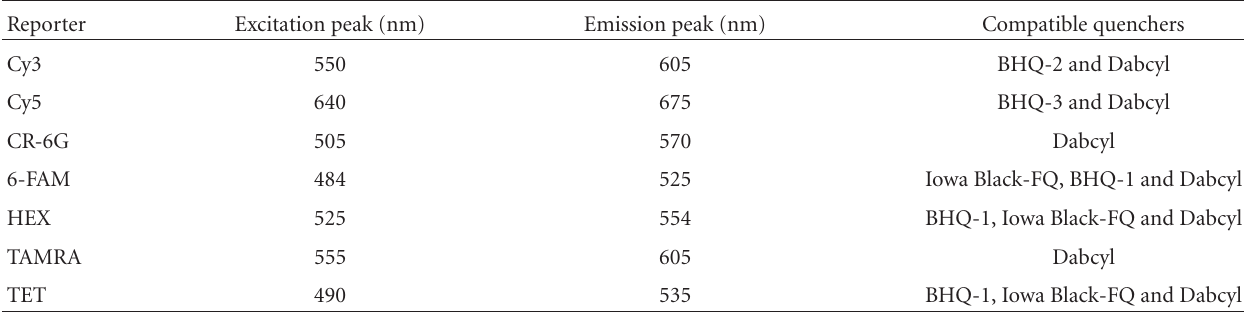
Table 1: Reporter-quencher pairs. For every one reporter is showed the peak of excitation, emission, and also the quenchers that could be used for observing a high quenching e ffi ciency. The excitation peak and emission peak values were obtained from reference